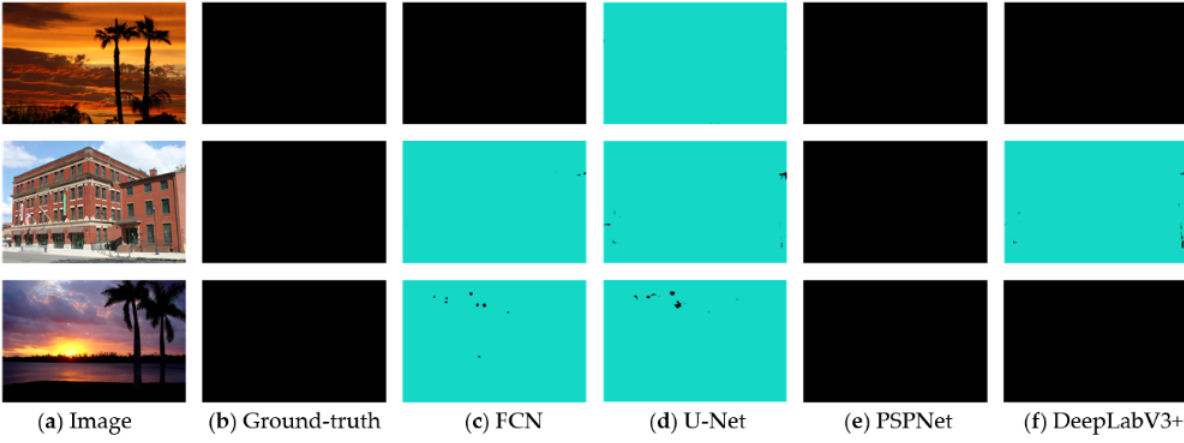
Figure 10. Results of Interference image segmentation.